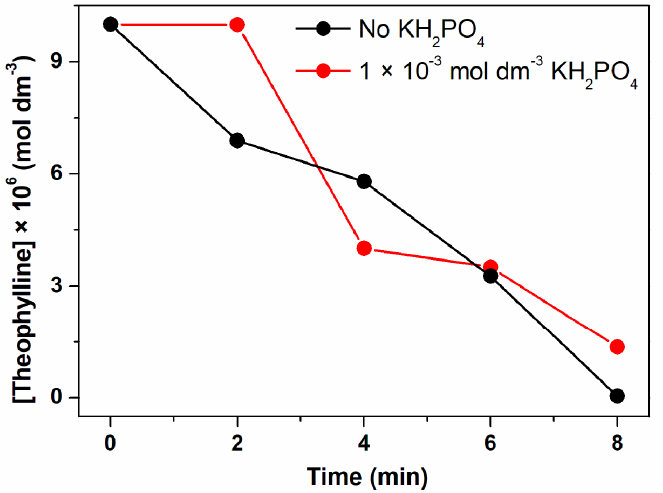
Figure 3. Photo-degradation profile of theophylline (1 × 10 − 5 mol dm − 3 ) in the presence of (black) 5 × 10 − 5 mol dm − 3 H 2 O 2 and in the presence of (red) 1 × 10 − 3 mol dm − 3 potassium dihydrogen phosphate.